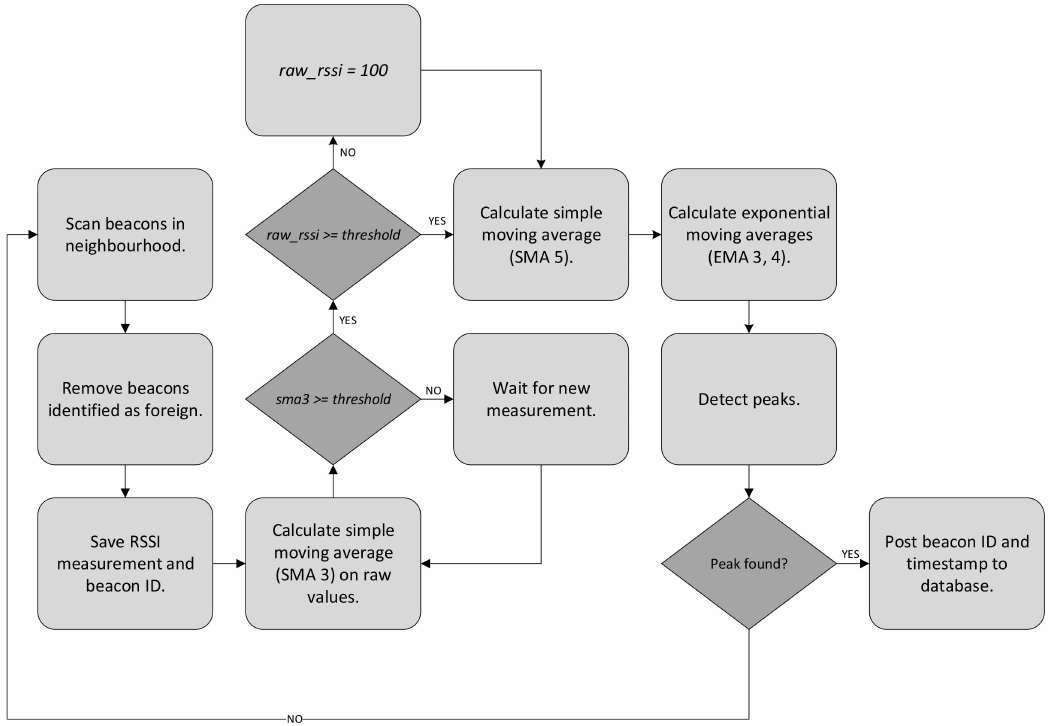
Figure 7. Real-time detection